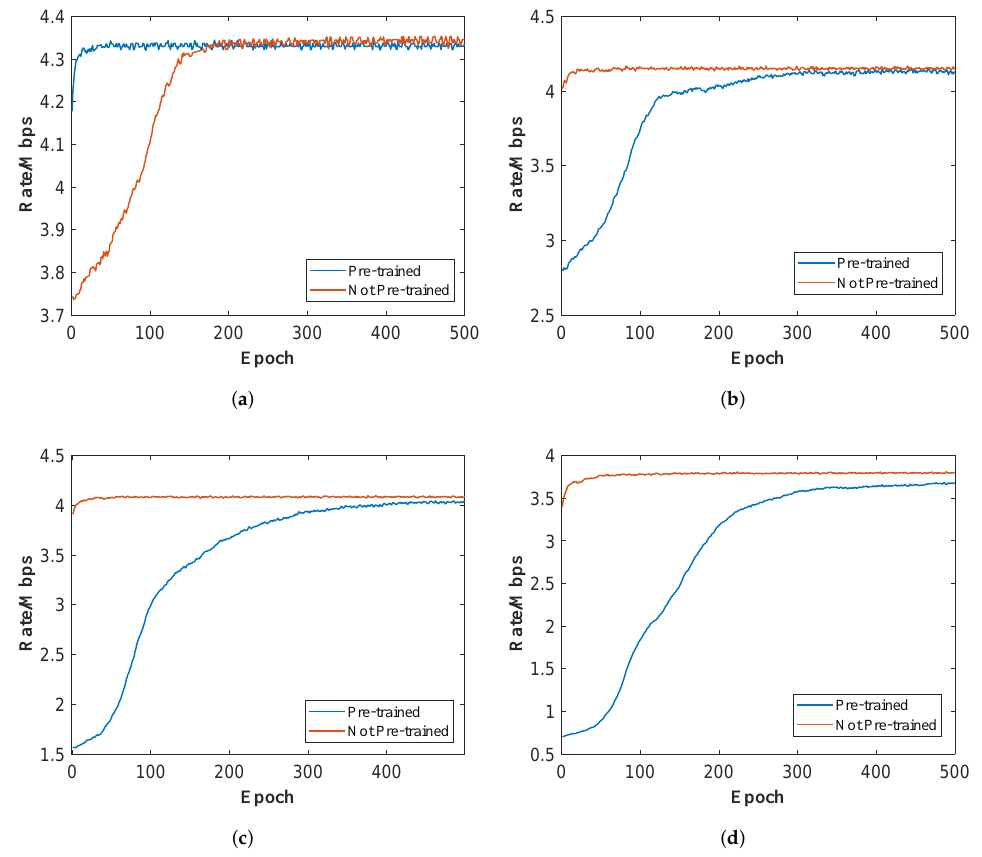
Figure 6. Converge performance for pre-trained and non-pre-trained LGNN. ( a ) V s = 10, V u = 2. ( b ) V s = 15, V u = 3. ( c ) V s = 20, V u = 5. ( d ) V s = 50, V u =